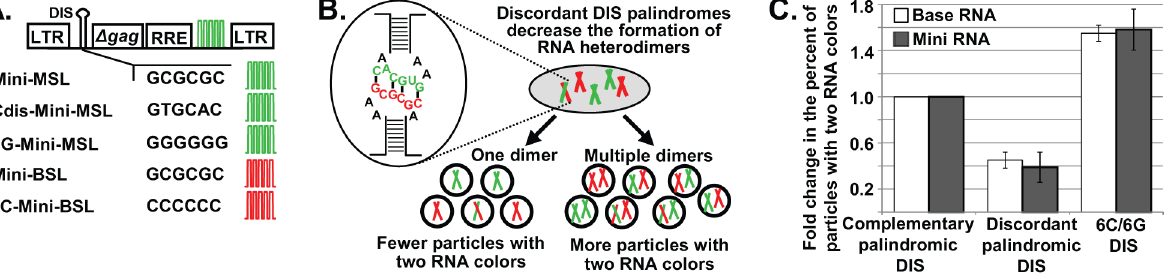
Figure 3. The regulation of short HIV-1 RNA packaging. (A) General structures of Mini HIV-1 constructs. The first 200 nt of gag is shown as D gag ; RRE, Rev-response element; DIS, dimerization initiation signal. Other abbreviations are the same as in Figure 1. (B) Schematic representation of predicted outcomes when Mini RNAs are packaged as one dimer or more than one dimer with two constructs containing discordant DIS palindromes. (C) Effects of DIS sequences on the generation of two-RNA-color (YFP + mCherry + ) particles containing Base (white bars) and Mini (gray bars) RNAs. The ratio of YFP + mCherry + particles from two constructs that both contain GCGCGC in their DIS was set as 1. Data for Base RNAs were recalculated from data described in [16]. Values for Mini RNAs represent the mean 6 SD from 5 independent